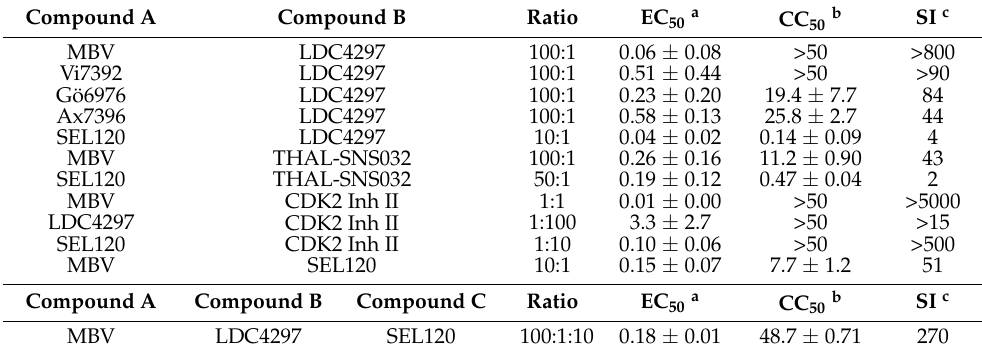
Table 2. Combination treatments: anti-HCMV-specific EC 50 , HFF-specific CC 50 and SI values of selected PKI combinations. Compound A Compound